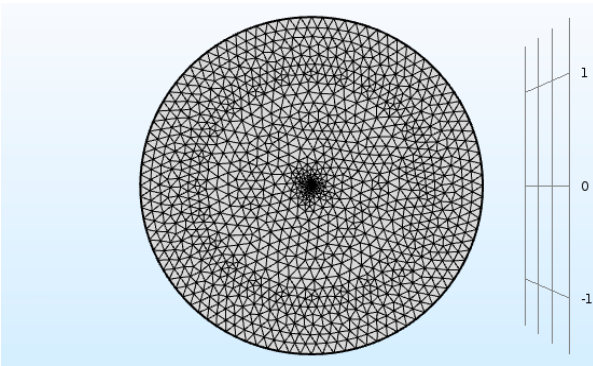
Figure 2. A schematic view of the geometry meshing with 34,269 components.